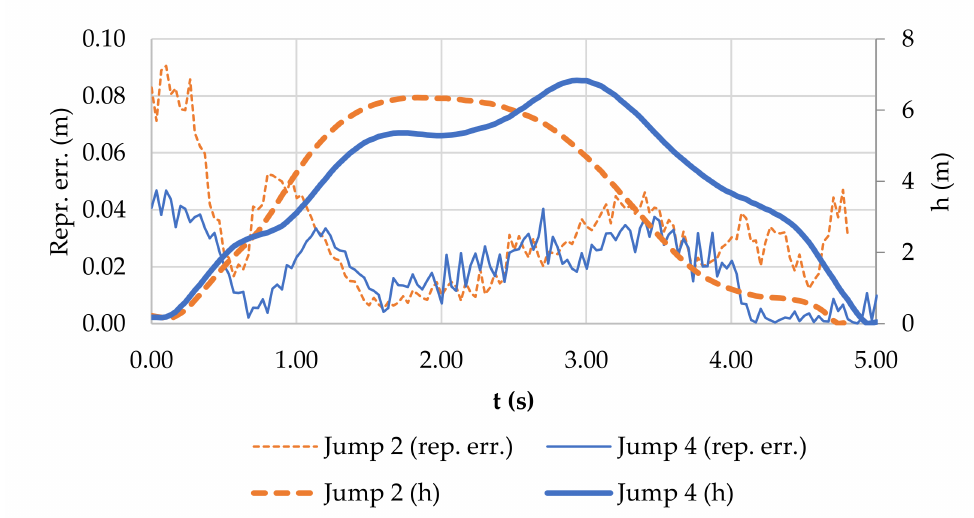
Figure 10. Reprojection error converted to the object plane using the GSD and jump height versus time for Jumps 2 and